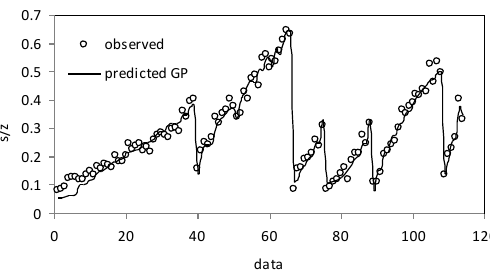
Figure 15. GP estimations of s/z versus measured ones 00.20.40.60.811.21.41.61.8